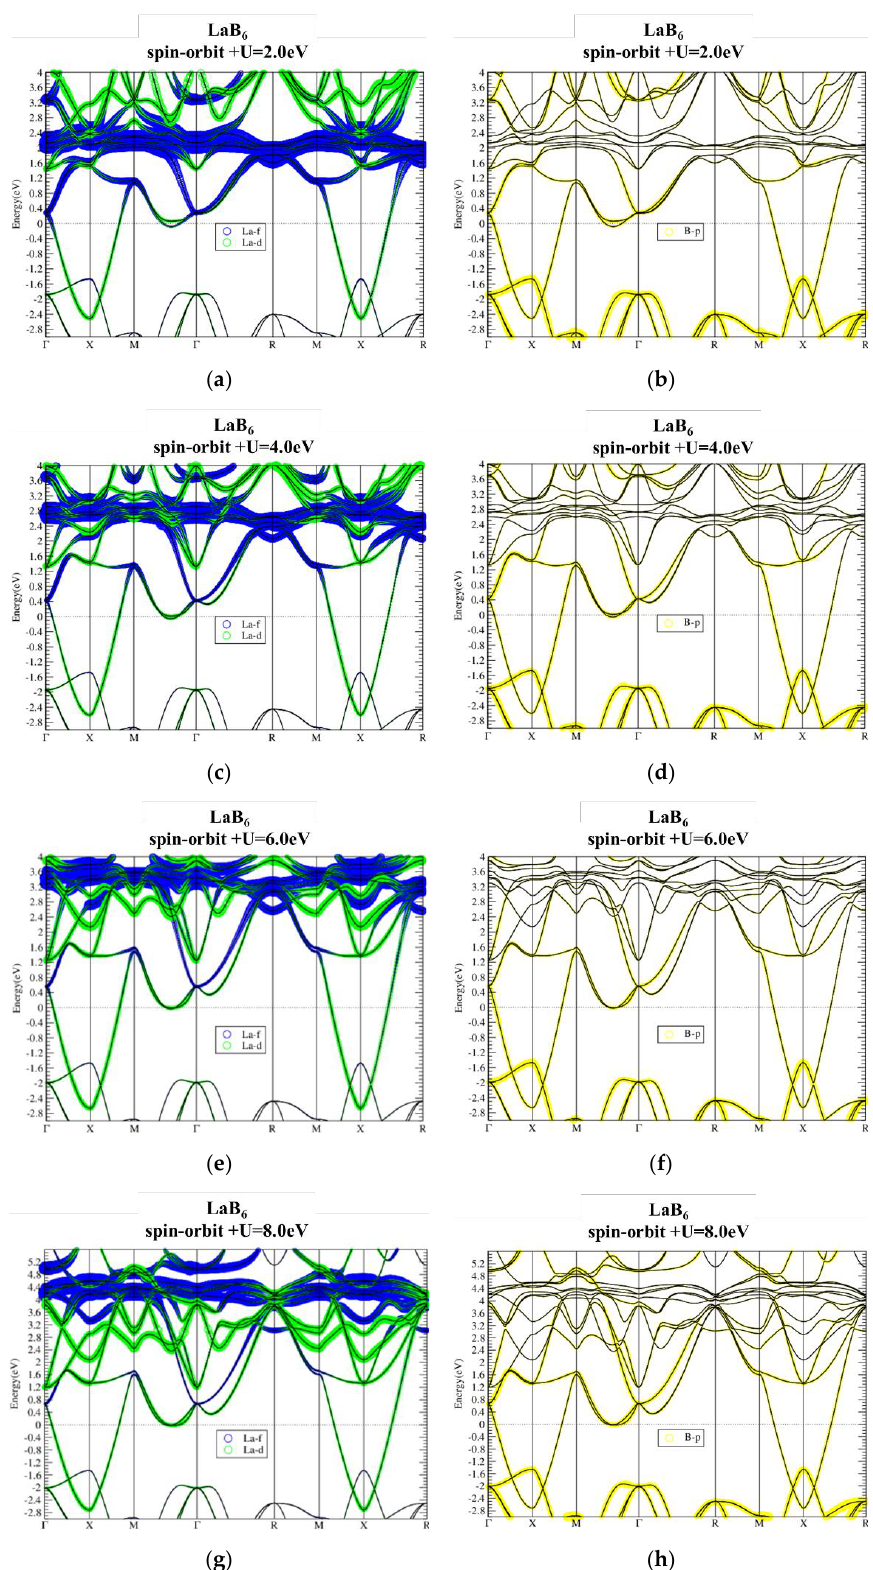
Figure 3. Atom-orbital decomposed band structures of LaB 6 with on-site U = 2 eV ( a , b ), 4 eV ( c , d ), 6 eV ( e , f ), and 8 eV ( g , h